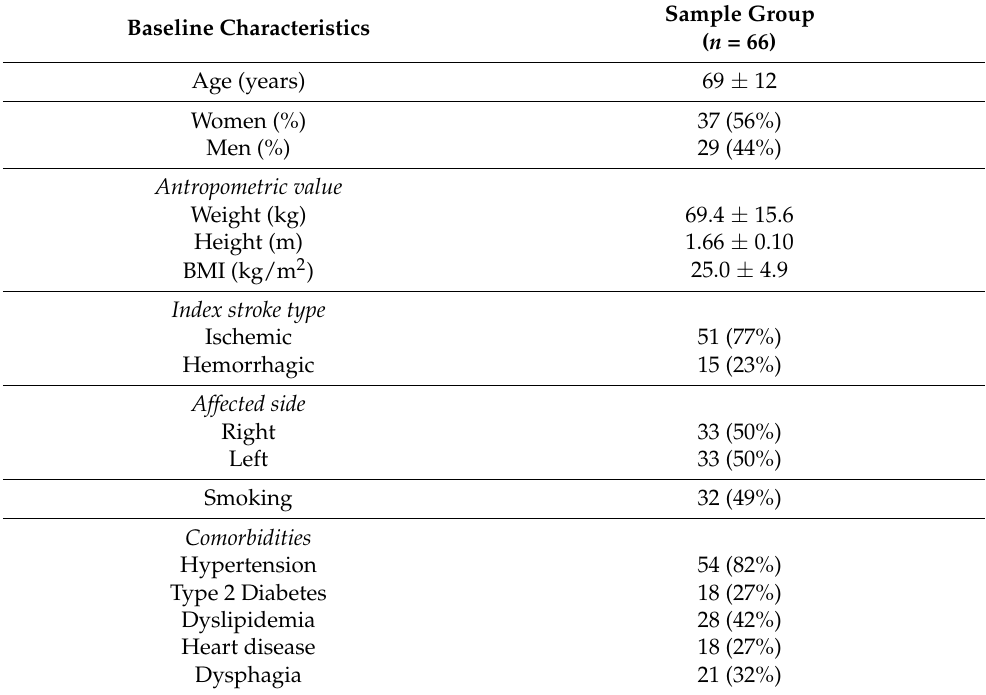
Table 1. Baseline characteristics of the sample ( n = 66). Data are reported in mean ± standard deviation or number